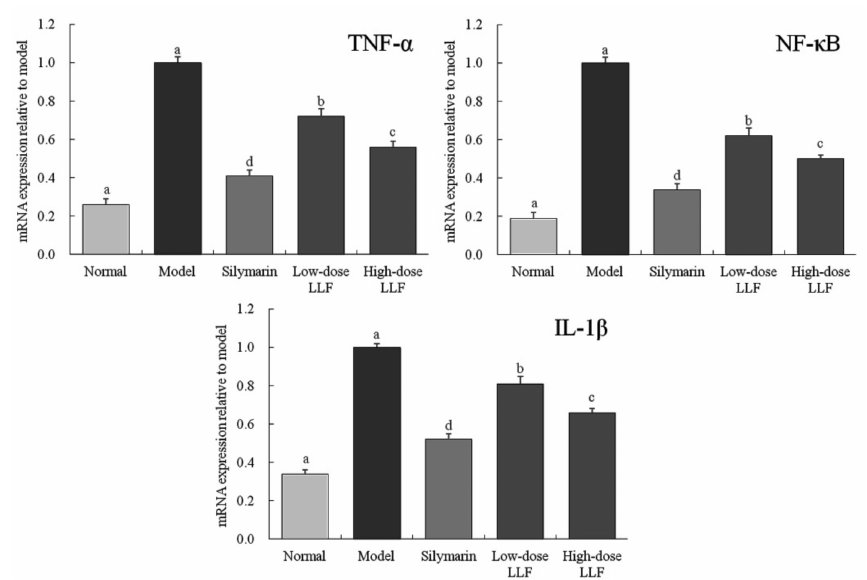
Figure 4. TNF- α , NF- κ B , and IL-1 β mRNA expression in liver tissues of the mice. Sample data in each group came from a normal distribution. a–e Mean values with di ff erent letters in the bar are significantly di ff erent ( p < 0.05) according to Tukey’s honestly significant di ff erent test. Silymarin: mice treated with silymarin (100 mg / kg); low-dose LLF: mice treated with a low concentration of lotus leaf flavonoids (50 mg / kg); high-dose LLF: mice treated with a high concentration of lotus leaf flavonoids (100 mg /